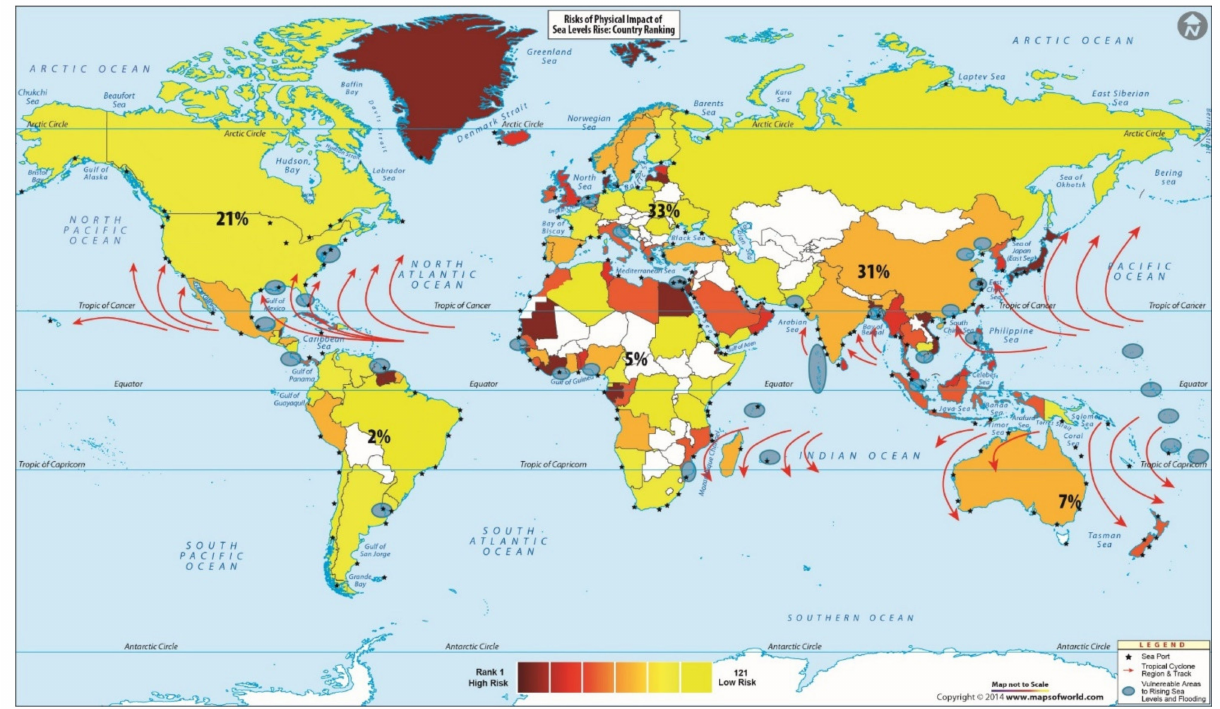
Figure A4. Map of extreme weather, its risks of physical impact by country ranking and sea level rising conditions globally (Courtesy: